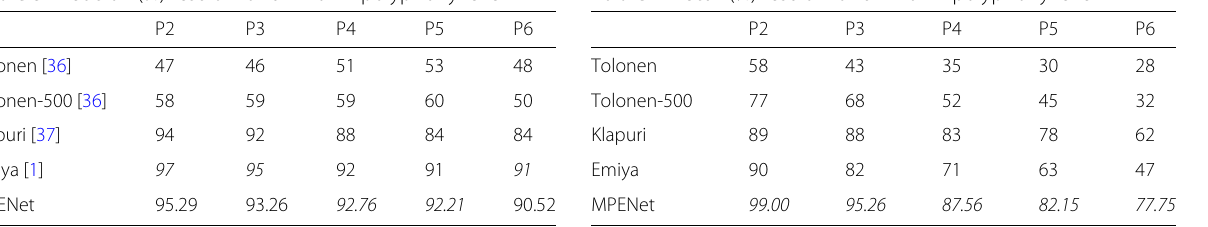
at the time. It has nothing to do with deep learning and can be implemented by any language. The form of L is the extension of binary labels to impose classification infor- mation, because there are no note probabilities but only codings on our